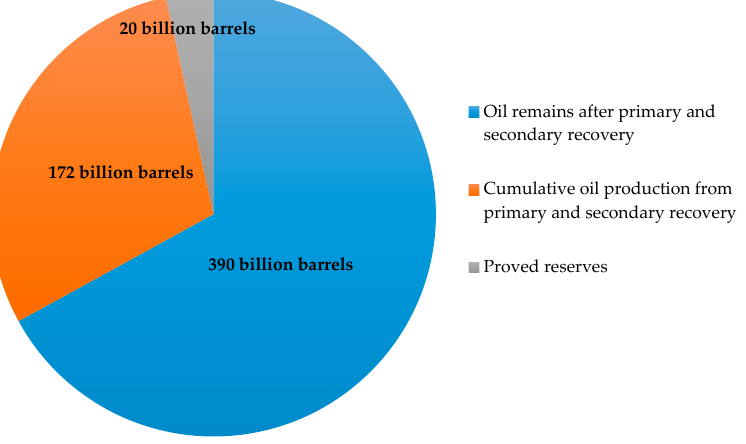
Figure 1. Oil production ability by primary/secondary recovery techniques [3].